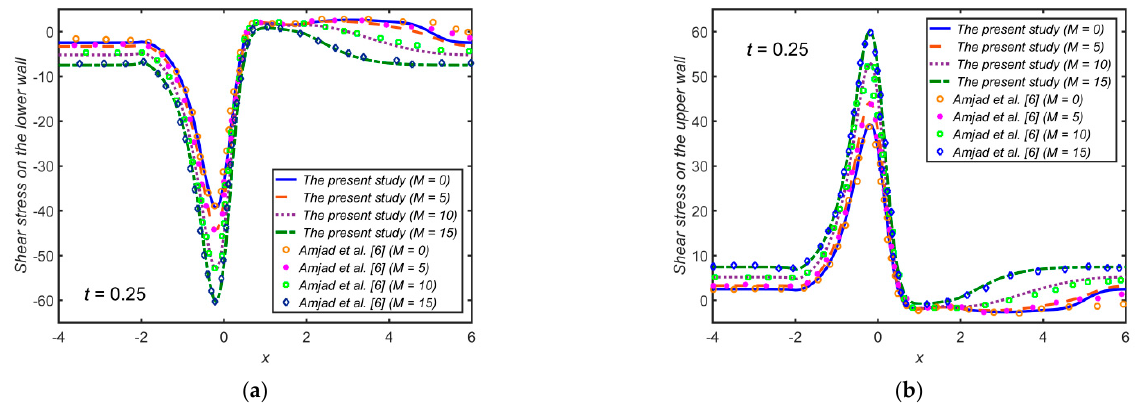
Figure 2. The WSS distribution for distinct values of the Hartmann number 𝑀 ( a ) on the lower wall; ( b ) on the upper wall.